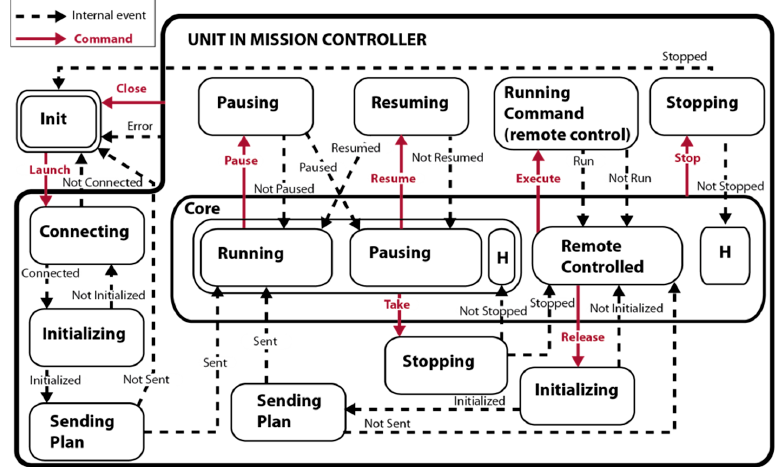
Figure 3. The state diagram of a unit controller for a mission.